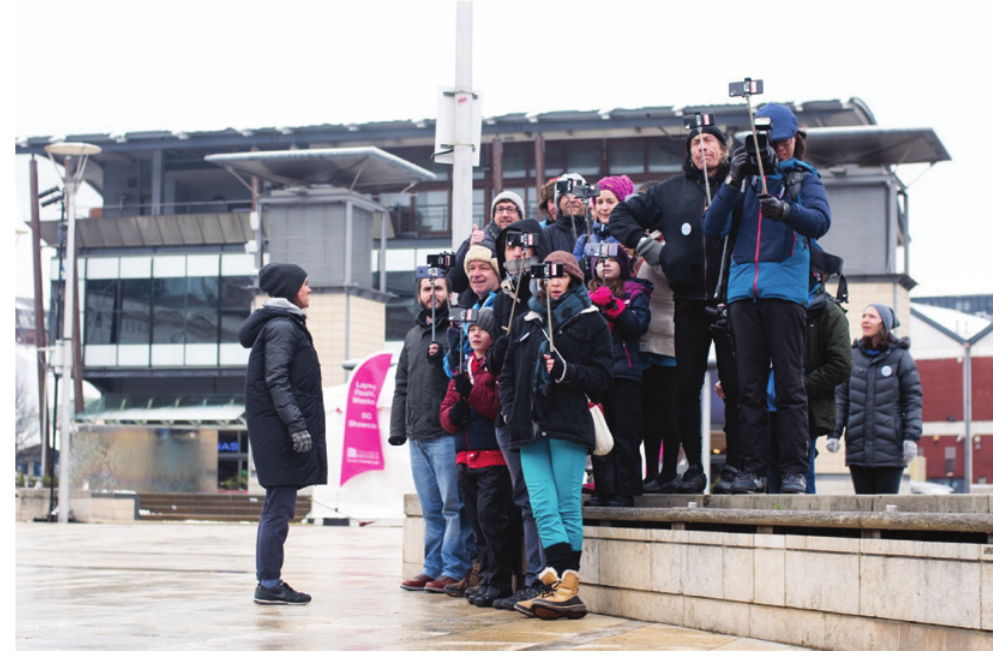
figure 1: Billennium , Uninvited Guests and Duncan speakman, Layered Realities , Millennium square, 2018 (photograph: Jon